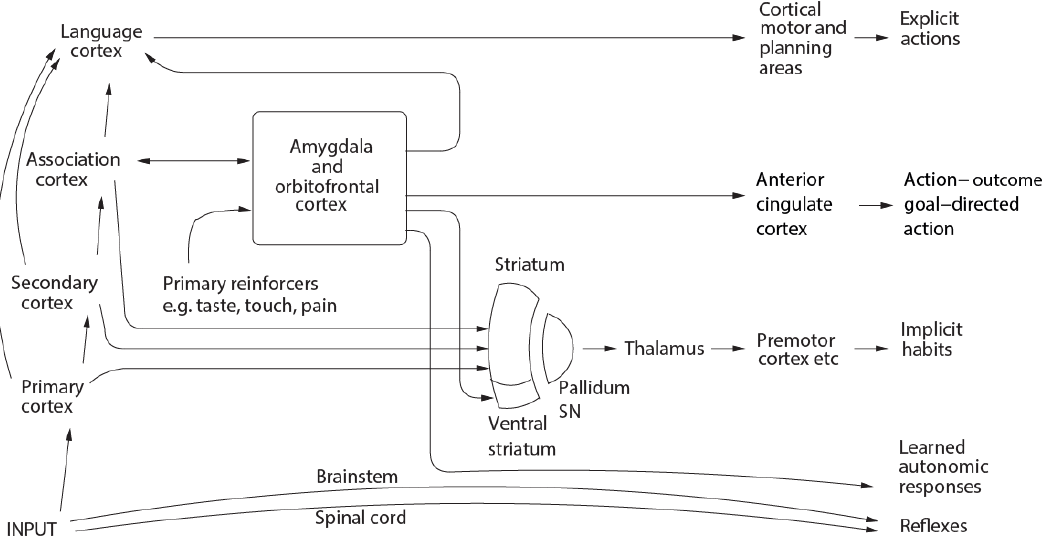
Figure 1 : Multiple routes to the initiation of actions and responses to rewarding and punishing stimuli. The inputs from different sensory systems to brain structures such as the orbitofrontal cortex and amygdala allow these brain structures to evaluate the reward- or punishment-related value of incoming stimuli, or of remembered stimuli. One type of route is via the language systems of the brain, which allow explicit (verbalizable) decisions involving multistep syntactic planning to be implemented. The other type of route may be implicit, and includes the anterior cingulate cortex for action-outcome, goal-dependent, learning; and the striatum and rest of the basal ganglia for stimulus-response habits. Pallidum / SN - the globus pallidus and substantia nigra. Outputs for autonomic responses can also be produced using outputs from the orbitofrontal cortex and anterior cingulate cortex (some of which are routed via the ventral, visceral, part of the anterior insular cortex) and